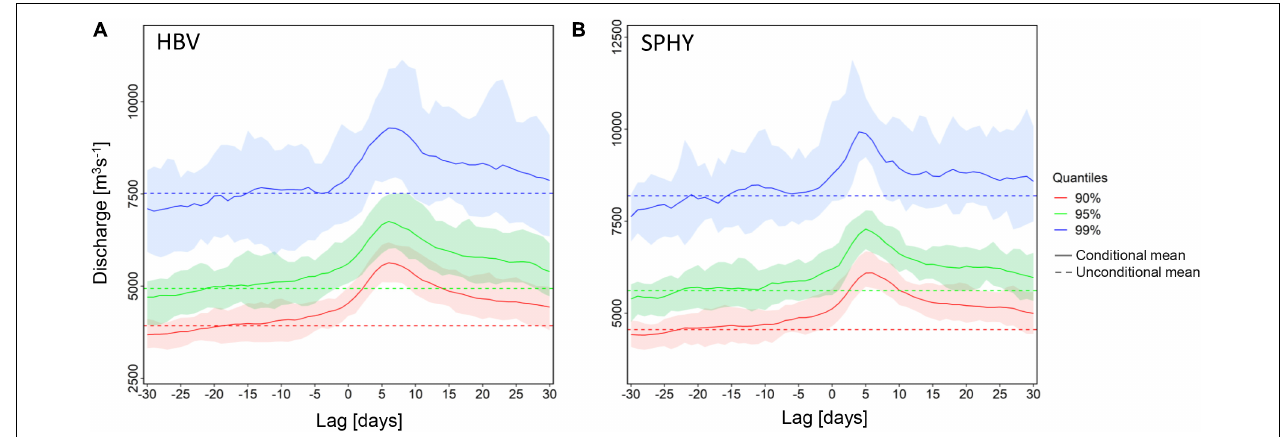
FIGURE 7 | Mean temporal evolution of the 90 th (red), 95 th (green) and 99 th (blue) quantile of discharge at Lobith for total water level events exceeding the 90 th quantile at HvH in WAQUA as modeled by HBV (A) and SPHY (B) . The lag in discharge at Lobith is relative to the peak in total sea water level at HvH. Negative and positive lag days indicate that the discharge peak occurs before and after the day of the high sea water event. The dashed lines are the unconditional discharge quantiles, i.e. discharge quantiles independent of water level; solid lines are the ensemble mean of the conditional quantiles. The shaded area represents 16 different lines for each ensemble and we only took the 5 th and 95 th quantile of those 16 lines to show spread of 16 ensemble